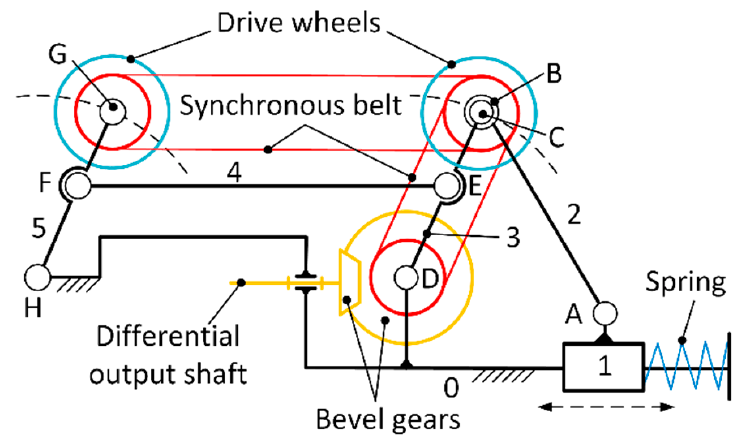
Figure 15. Adapting mechanism based on combined linkages.